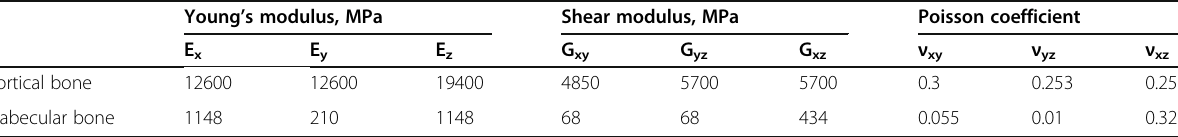
Table 1 Elastic properties adopted for the bone